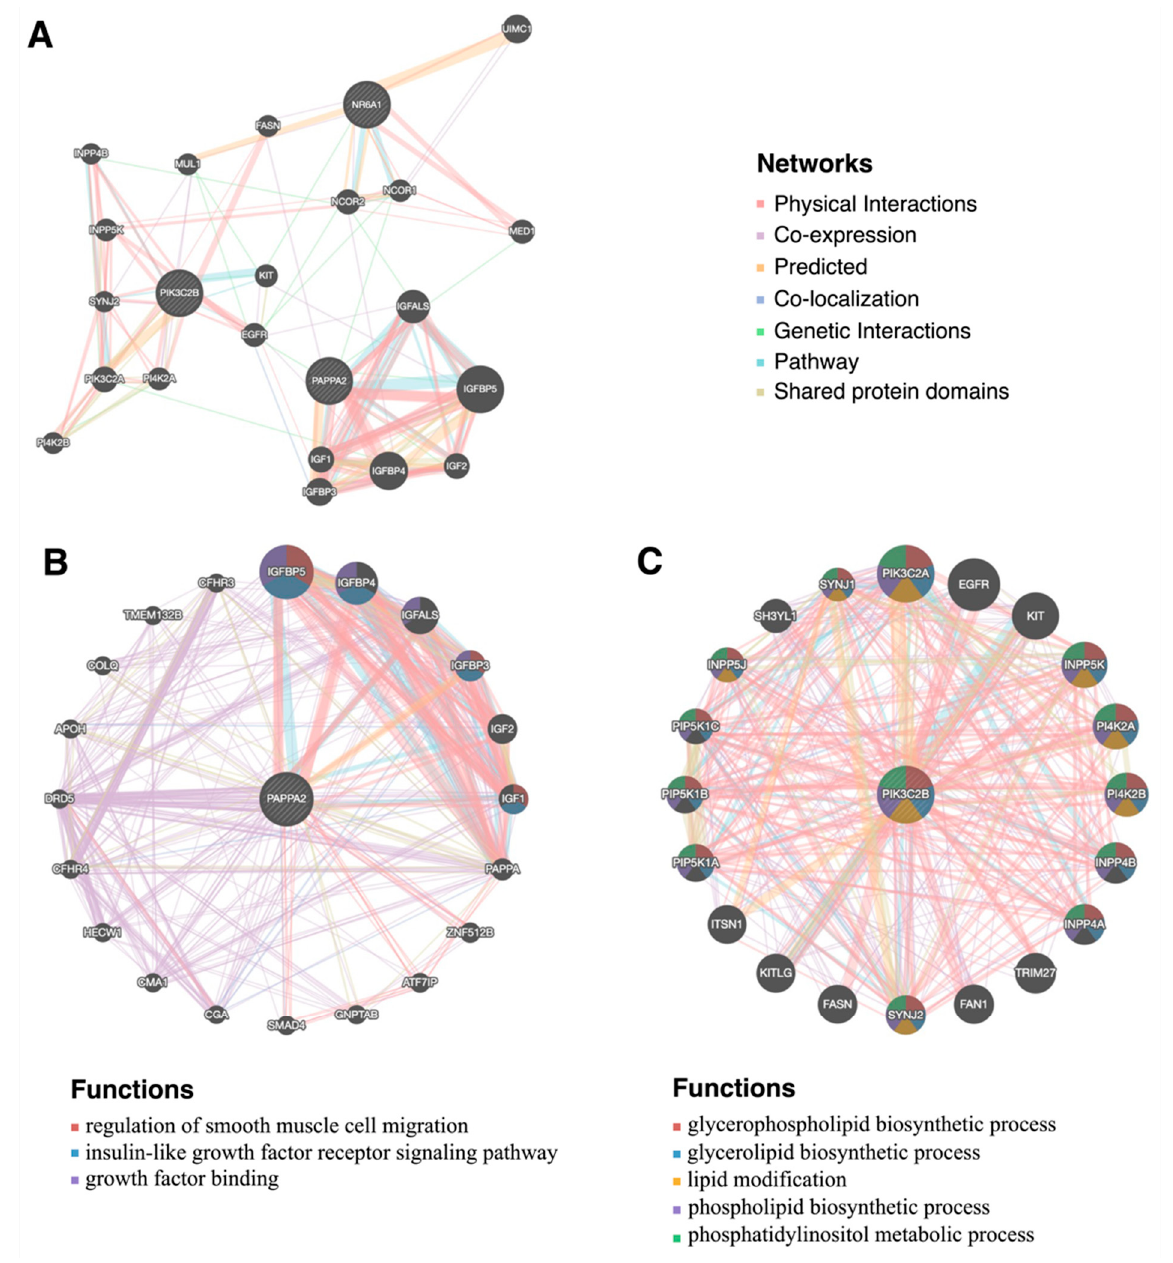
Figure 4. The PPI (protein–protein interaction) networks of NR6A1 , PAPPA2 , and PIK3C2B and its interacting protein partners. ( A ) The PPI networks of NR6A1 , PAPPA2 , and PIK3C2B . ( B ) The PPI networks of PAPPA2 and its interacting protein partners and functions. ( C ) The PPI networks of PIK3C2B and its interacting protein partners and functions.